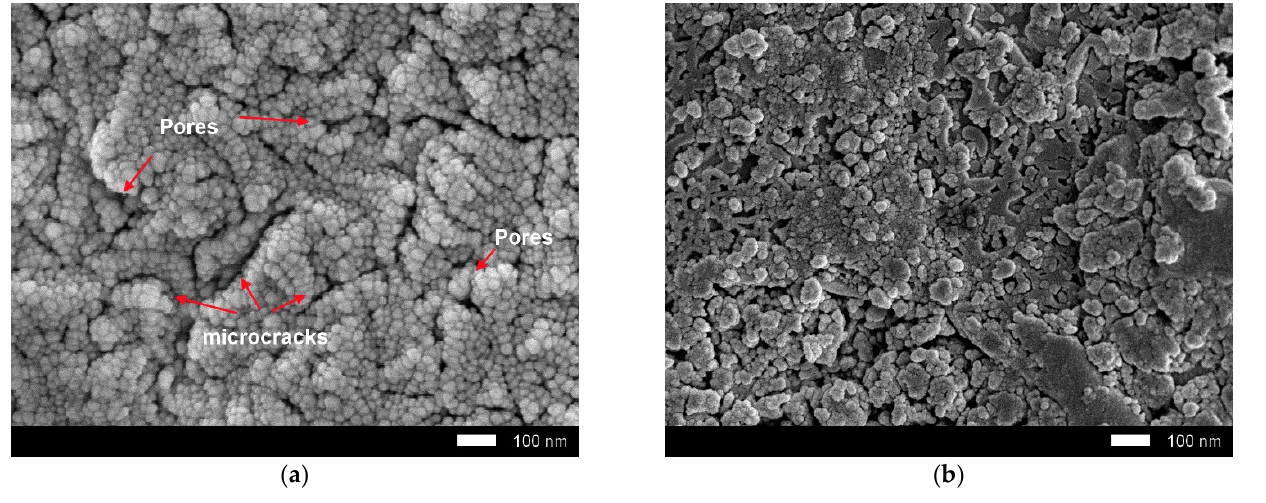
Figure 8. SEM images of the surface layer of ceramics after irradiation with fluences: ( a ) 5 × 10 15 ion/cm 2 ; ( b ) 10 16 ion/cm 2.